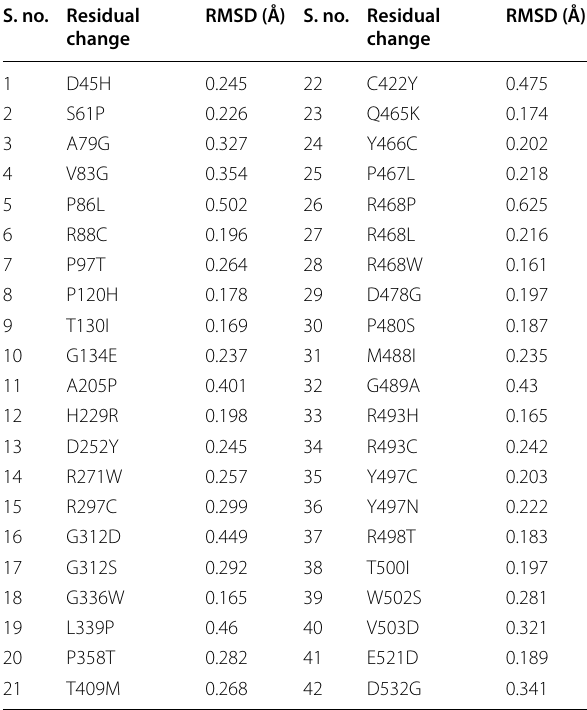
Table 4 List of ns‑SNPs predicted as deleterious through RMSD calculation through